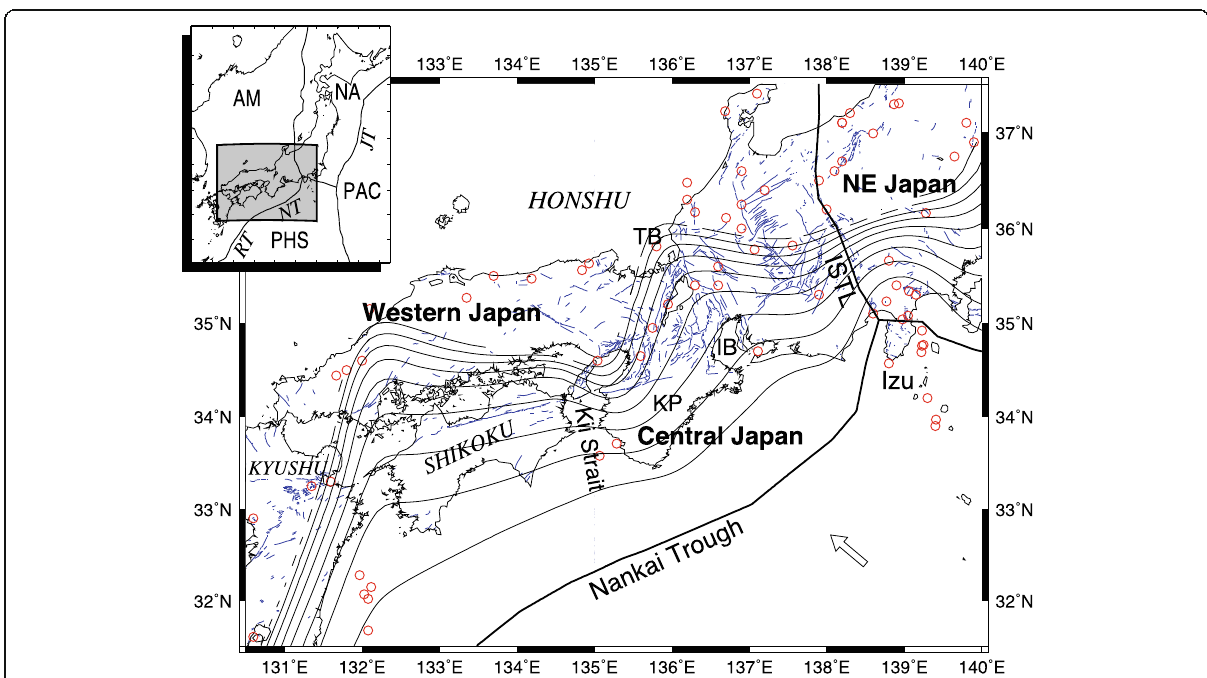
Fig. 1 Location map of central and western Japan. Thick solid lines represent plate boundaries after Bird (2003). Red open circles are epicenters of very shallow ( ≤ 20 km), historical (1586 ≤ year ≤ 2013), and large ( M ≥ 6.5) earthquakes from the Catalog of Damaging Earthquakes in the World (Utsu 1990, 2002, 2004, the later updates are added by the International Institute of Seismology and Earthquake Engineering) with additional depth data for historical earthquakes (Matsu ’ ura 2017). Thin blue lines are active faults on land (Research Group for Active Faults of Japan 1991). Contour lines of the PHS slab of the CAMP model (Hashimoto et al. 2004) are also shown every 10 km by thin solid lines. The following acronyms are used: ISTL, Itoigawa-Shizuoka tectonic line; KP, Kii Peninsula; IB, Ise Bay; TB, Tsuruga Bay; NE, northeastern; AM, Amurian Plate; PHS, Philippine Sea Plate; PAC, Pacific Plate; NA, North American Plate; JT, Japan Trench; NT; Nankai Trough; RT, Ryukyu